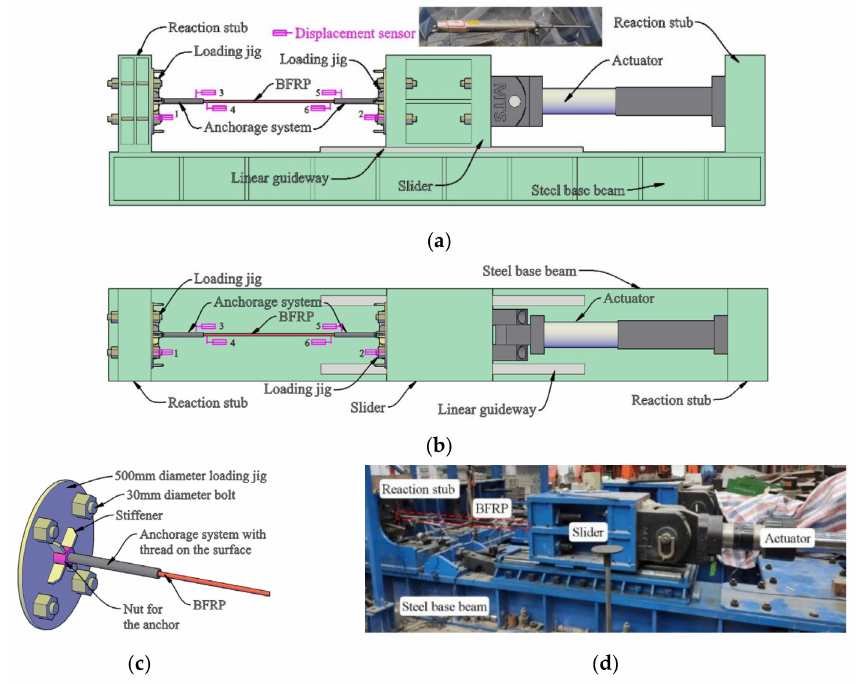
Figure 2. Setup for uniaxial loading of BFRP tendon: ( a ) side view; ( b ) top view; ( c ) fixing detail of BFRP; ( d ) experiment